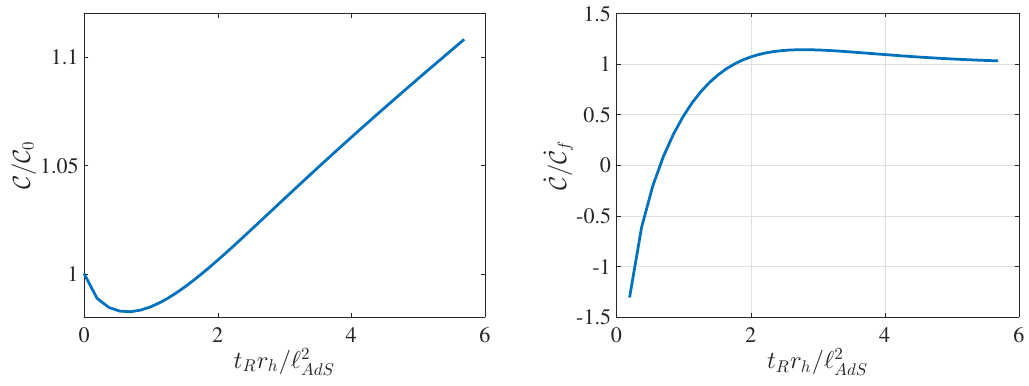
Figure 3 . The complexity C ( j TFD(0 ; t R ) i ; j 0 i ) and their growth rates for the BTZ black hole. C 0 is the complexity when t R = 0 and _ C f = 2 M=(cid:25) ~